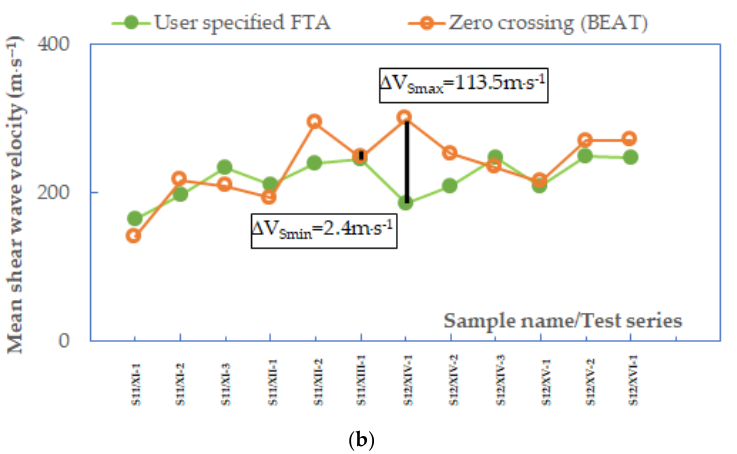
Figure 13. Mean values of shear wave velocities from the first time of arrival and zero-crossing methods when f < 3.3 kHz, data for specimens ( a ) S1–S10 and ( b ) S11–S12.